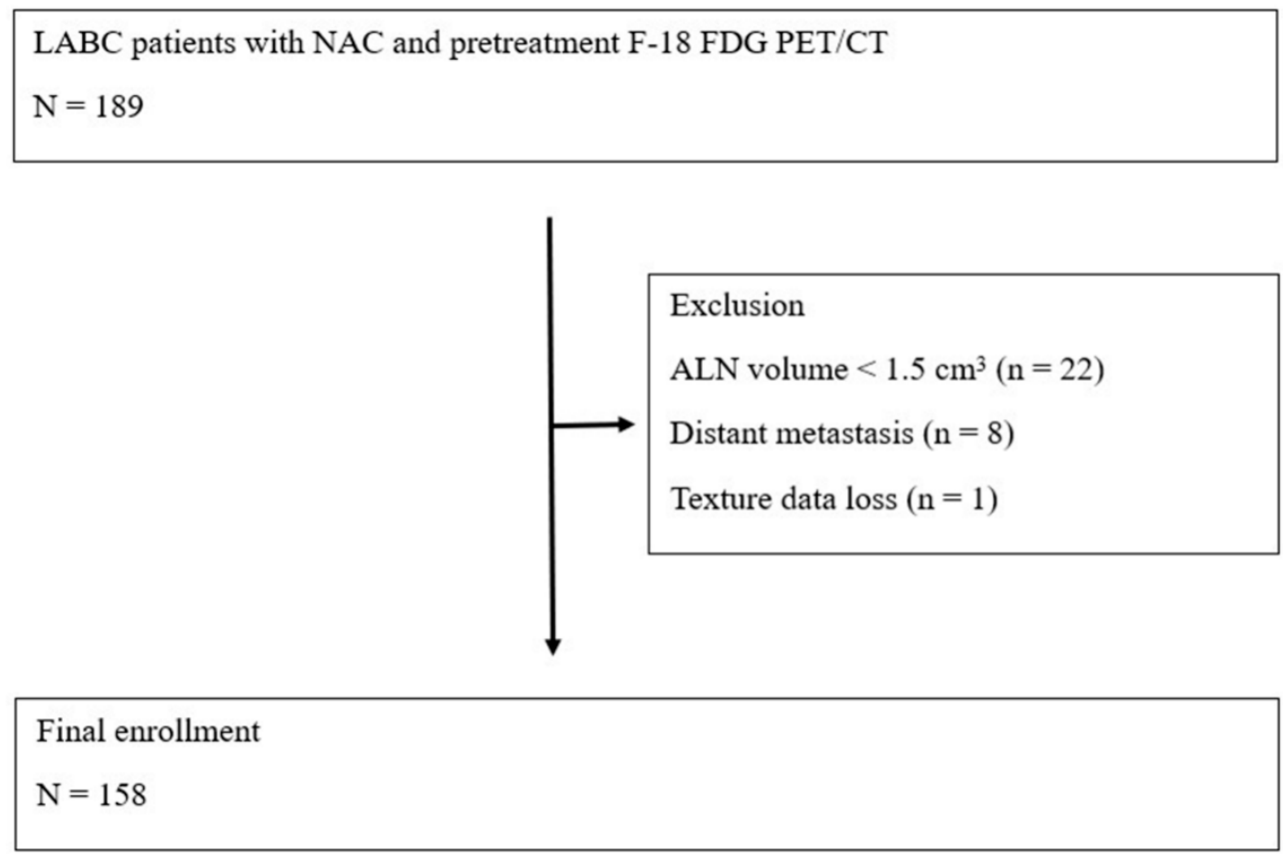
Figure 1. Patient enrollment flow chart.